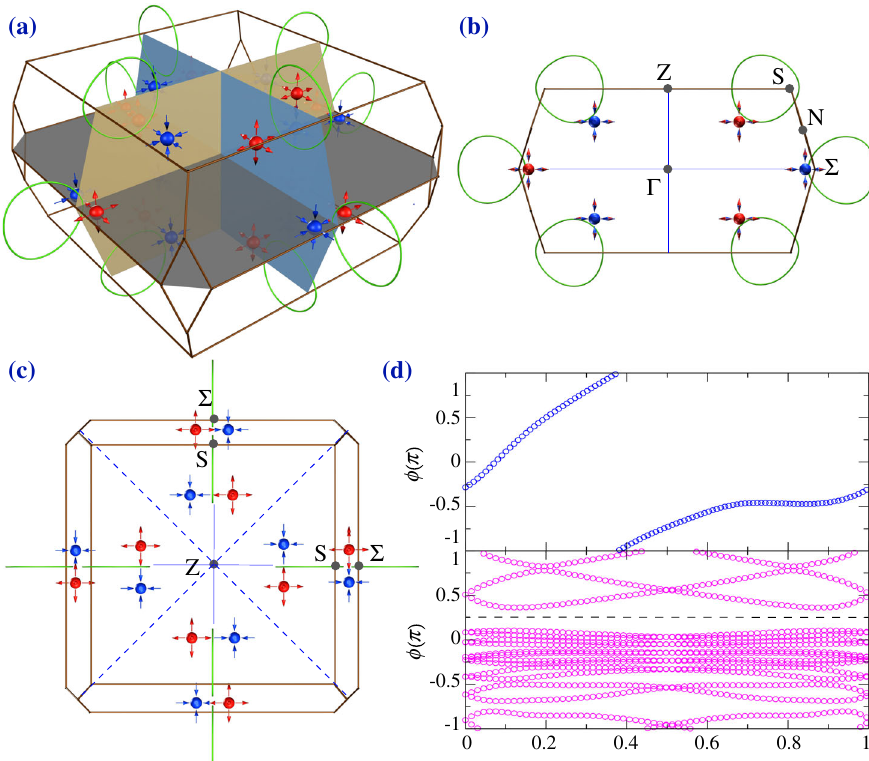
FIG. 2. Nodal rings and Weyl points distribution, as well as Z 2 and MCN for mirror planes. (a) 3D view of the nodal rings (in the absence of SOC) and Weyl points (with SOC) in the BZ. (b) Side view from [100] and (c) top view from [001] directions for the nodal rings and Weyl points. Once the SOC is turned on, the nodal rings are gapped and give rise to Weyl points off the mirror planes (see movie in Supplemental Material [36]). (d) Top panel: Flow chart of the average position of the Wannier centers obtained by Wilson-loop calculation for bands with mirror eigenvalue i in the mirror plane ZN Γ . (d) Bottom panel: The flow chart of the Wannier centers obtained by Wilson-loop calculation for bands in the glide mirror plane ZX Γ . There is no crossing along the reference line (the dashed line), indicating the Z 2 index is